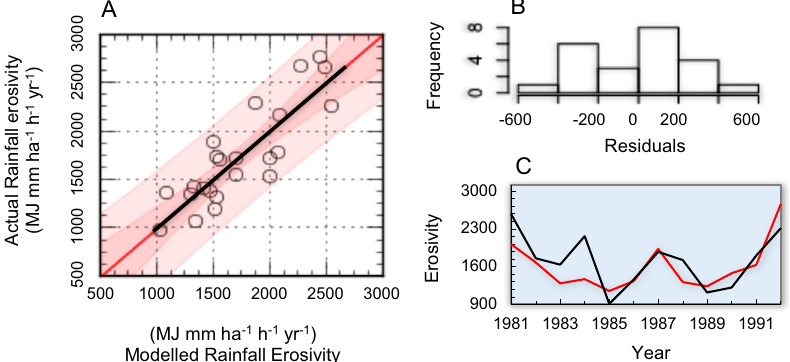
Fig. 3 Model calibration and validation. Scatter-plot of the regression model (black line, Eq. (1) and red line of identity) vs. actual rainfall erosivity estimated upon the Po River landscape over the period 1993 – 2015, with the inner bounds showing 95% con fi dence limits (power pink coloured area), and the outer bounds showing 90% prediction limits for new observations (light pink) ( A ). Residuals between actual and modelled erosivity at the calibration stage ( B ). Time co-evolution (1981 – 1992) of actual (black curve) and estimated (red curve) of rainfall erosivity at validation stage ( C